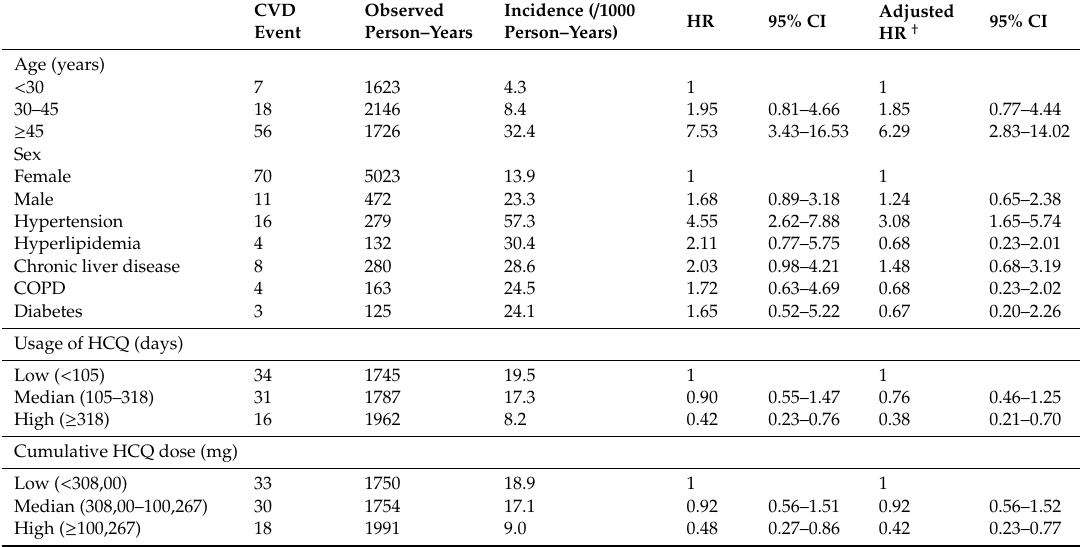
Table 2. HRs of developing CVD according to age, sex, comorbidity, usage, and cumulative dose of HCQ in the patients with SLE.